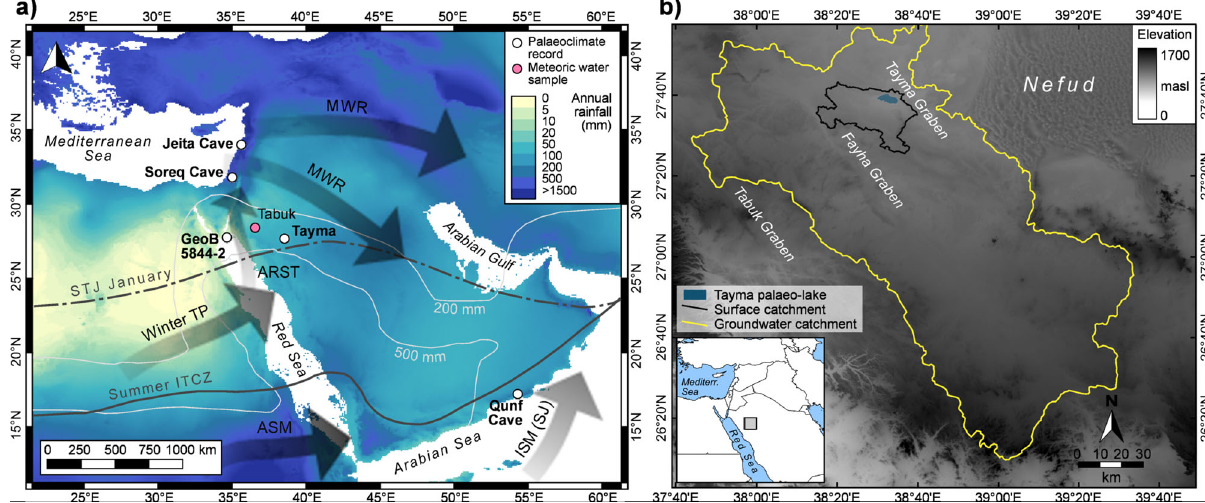
Fig. 1 Regional setting of Tayma. a Overview of the Arabian Peninsula and adjacent areas with the key palaeoclimate sites of Jeita Cave 28 , Soreq Cave 26,27 , GeoB 5844-2 in the Red Sea 13 and Qunf Cave 29 , mean annual rainfall 1970 – 2000 (WorldClim 2 dataset 77 ), average positions of the Intertropical Convergence Zone (ITCZ) in summer and the Subtropical Jet (STJ) in winter 78 , and atmospheric sources of regional precipitation (MWR Mediterranean winter rains, Winter TP winter tropical plumes, ASM African Summer Monsoon, ISM (SJ) Indian Summer Monsoon (Somali Jet), ARST Active Red Sea Trough) 14 . Isohyetes of 200 mm and 500 mm are adapted from the wettest simulation of the COSMOS climate model at 6000 BCE in ref. 12 . b Reconstructed extent of the Tayma palaeolake during its peak phase, today ’ s surface catchment and groundwater catchment 79 . The topography is based on GTOPO30 data 80